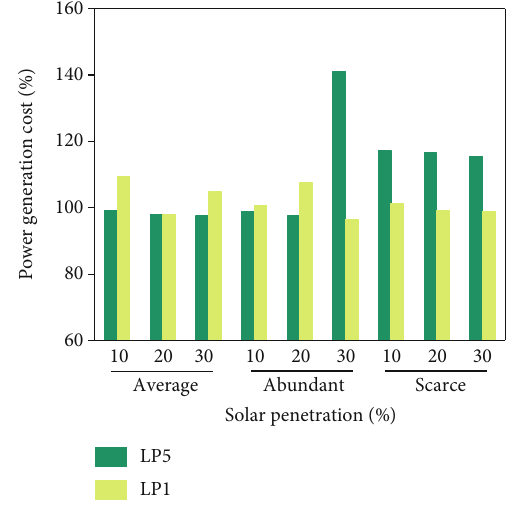
Figure 8: Power generation costs of the 24 h DED for LP5 and LP1 under average, abundant, and scarce solar resource